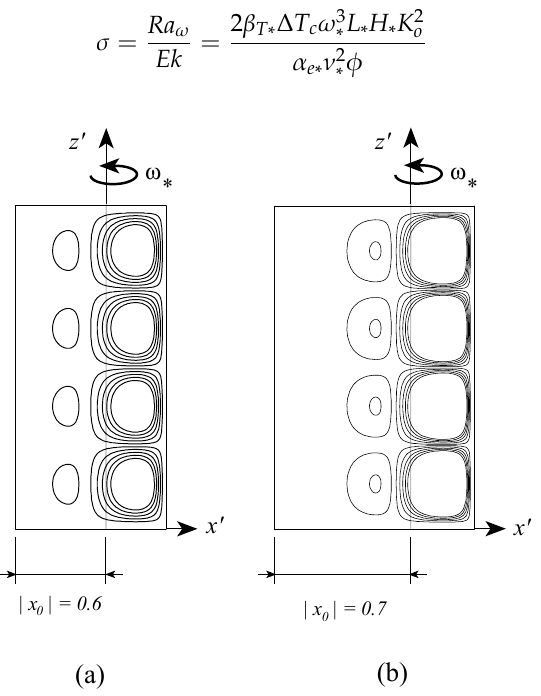
Figure 10. The convective flow field at marginal stability for two di ff erent values of | x 0 | ; 10 streamlines equally divided between ψ min and ψ max . ( a ) streamlines for the axis of rotation located at | x 0 | = 0.6; ( b ) streamlines for the axis of rotation located at | x 0 | = 0.7; (Reprinted from [41], with permission from Elsevier Science Ltd).